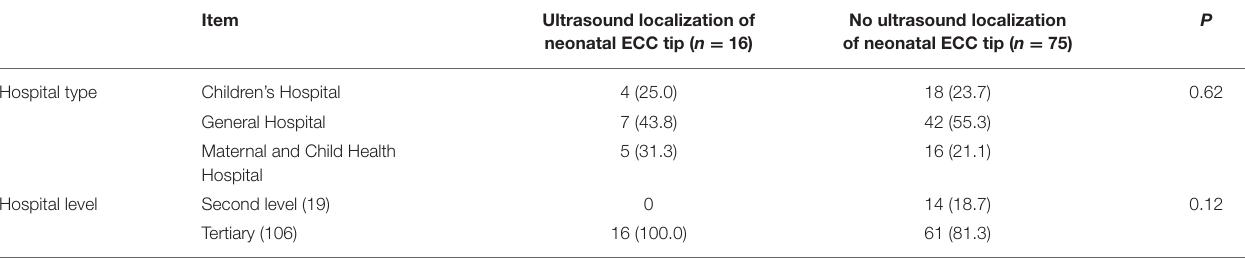
TABLE 2 | Current situation of ultrasound localization of newborns in hospitals [Institutes (percentage,%)].